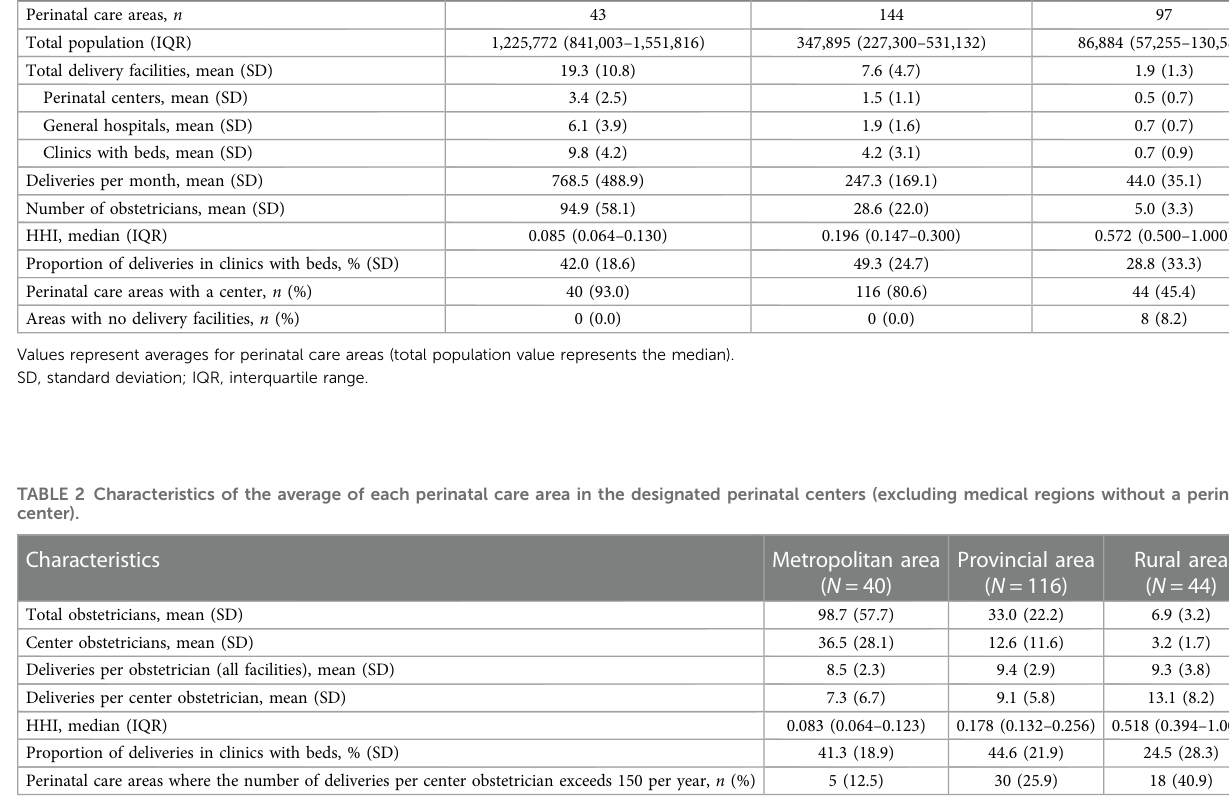
TABLE 1 Characteristics of each perinatal care area after categorization. Characteristics